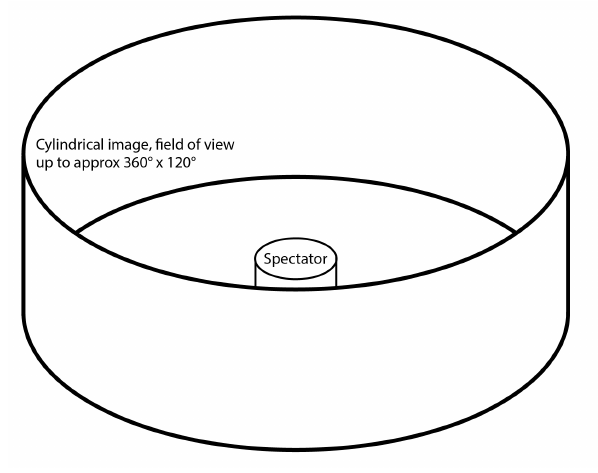
Figure 3. Panorama